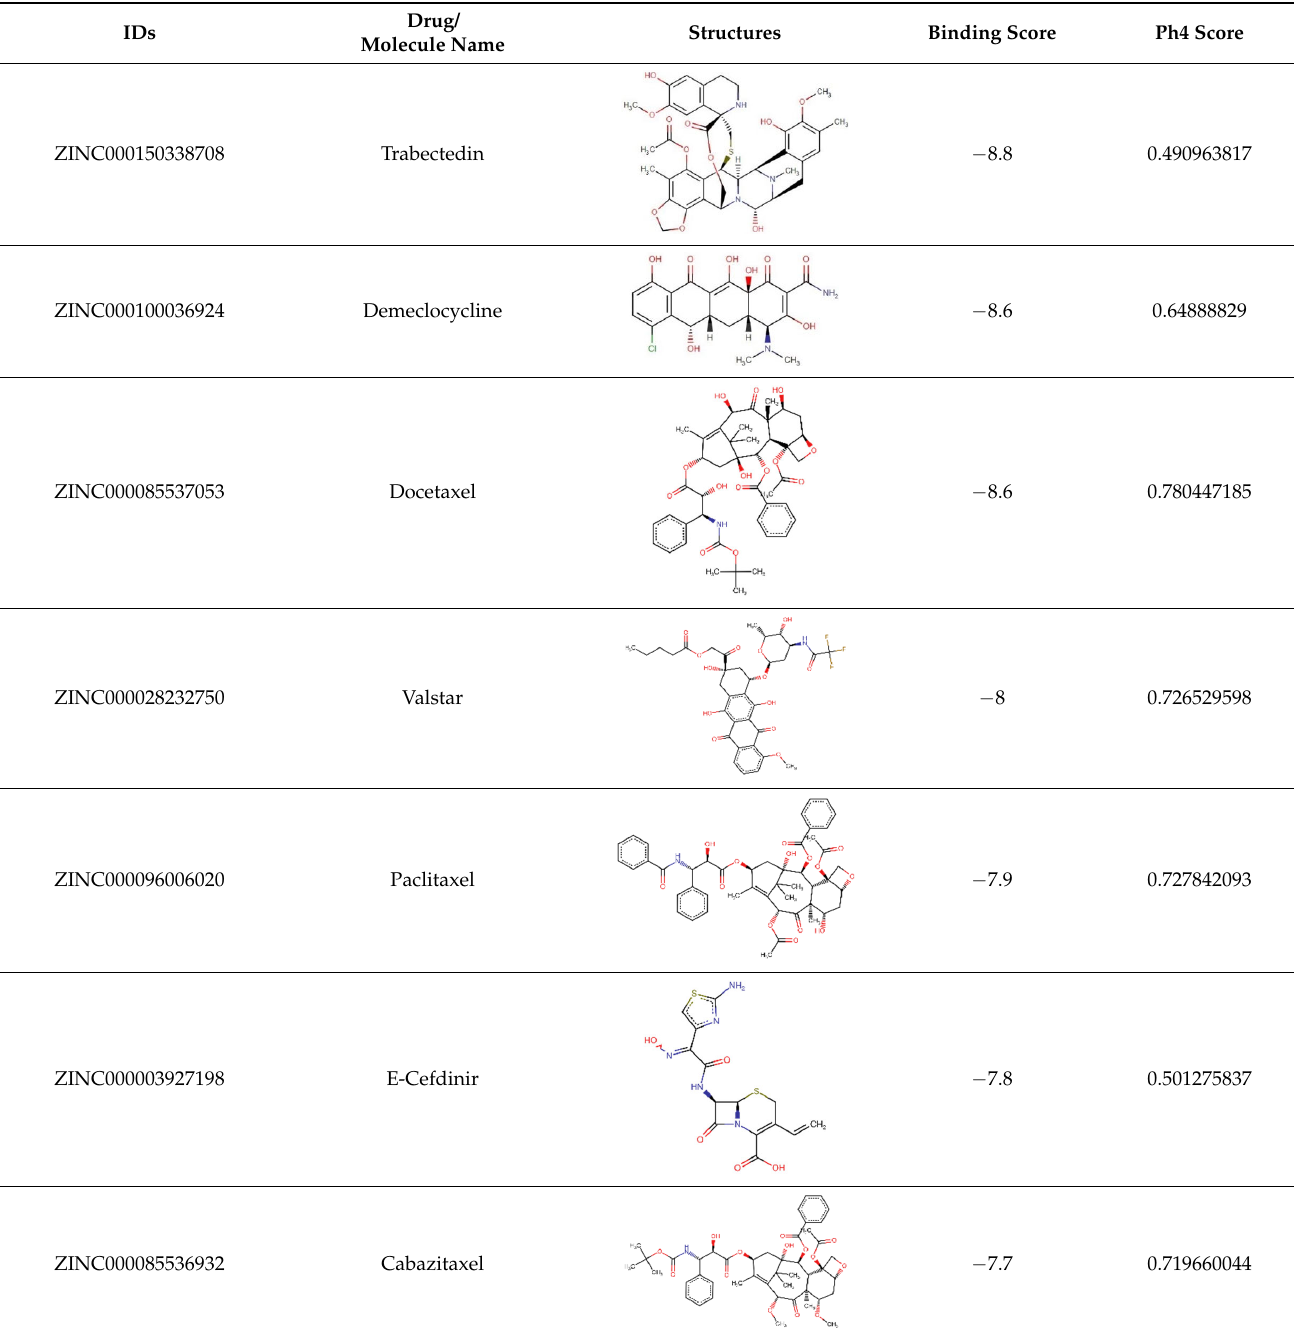
Table 2. Virtual screen output for computationally potential hits bind in the active site of α -glucosidase sorted based on binding affinity and Ph4 Score.